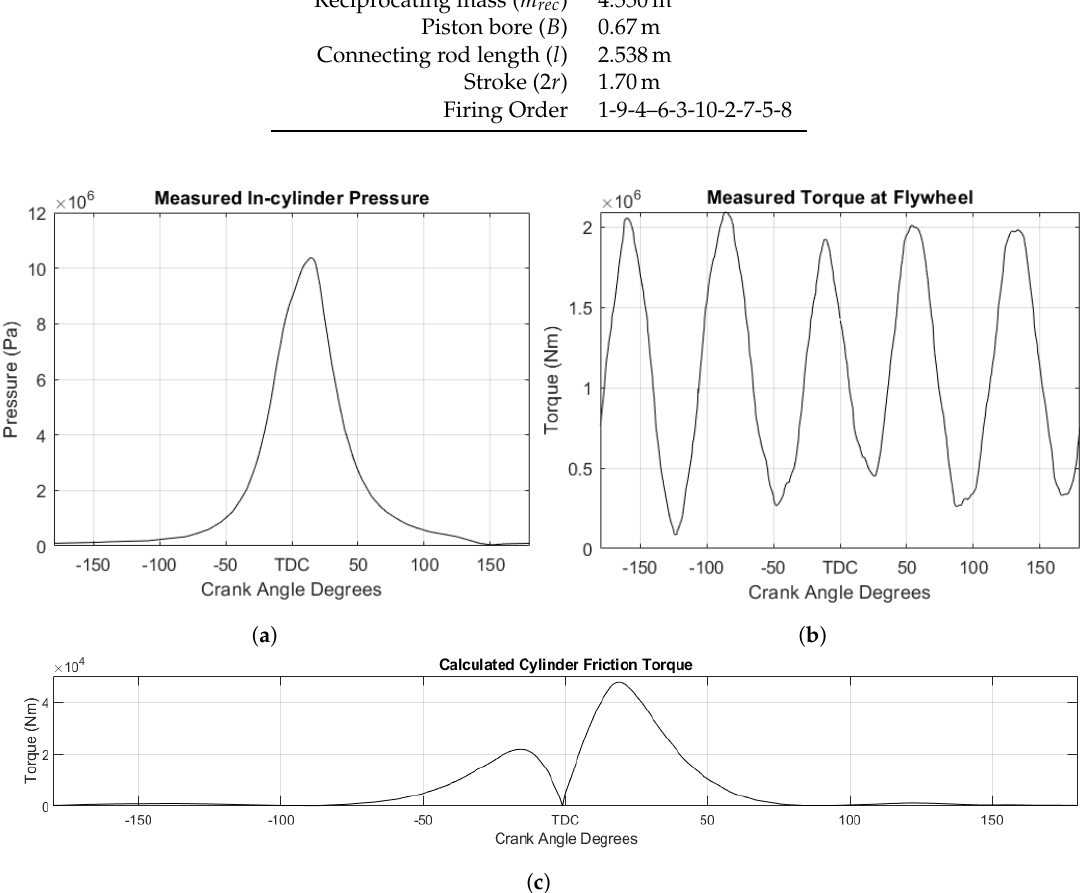
Figure 5. Reference system data of ( a ) in-cylinder pressure, ( b ) Instantaneous Crankshaft Torque (ICT), and ( c ) engine friction, all for 100% MCR at 13.8MW load from